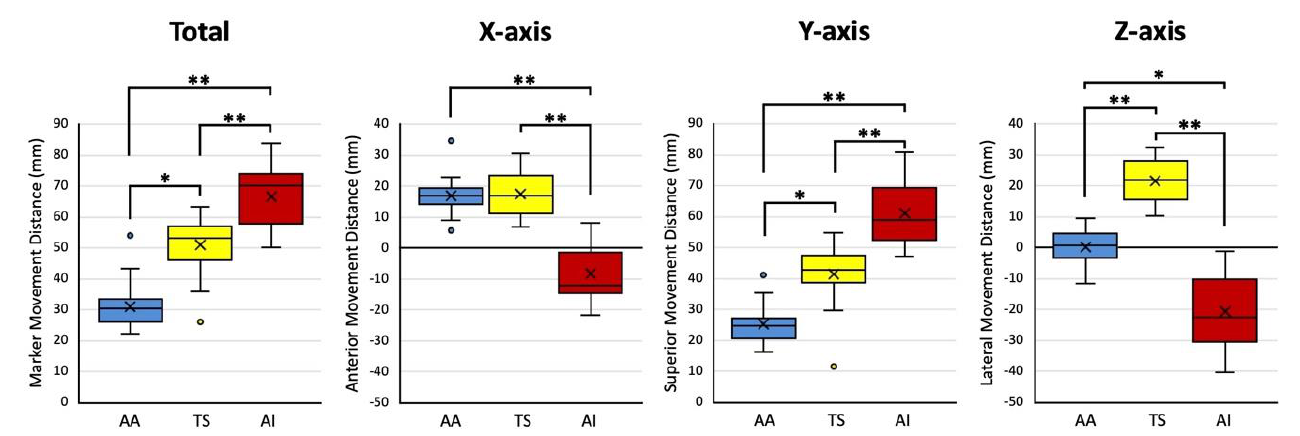
Figure 8. Boxplots of total, X-axis (anterior), Y-axis (superior), and Z-axis (lateral) marker movement distances of the acromial angle (angulus acromialis [AA]), root of the scapular spine (trigonum spinae scapulae [TS]), and inferior angle (angulus inferior [AI]). Box and whiskers quantify median, quartile, and extreme values. Outliers are shown with a black circle. “×” marks mean values. * p < 0.05; ** p < 0.01. The mean humerothoracic elevation angles were 4.3 ◦ ± 2.2 ◦ in the reference position and 146.1 ◦ ± 4.5 ◦ in the elevated position.